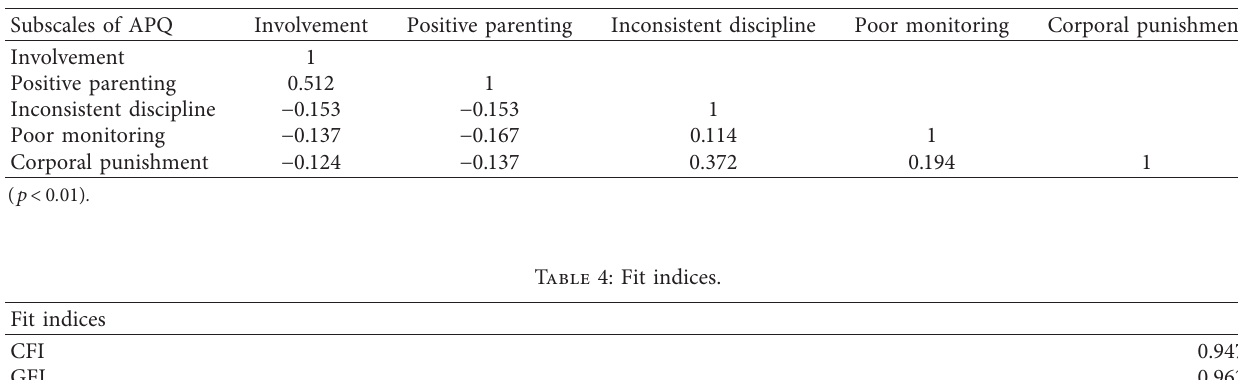
Table 3: Interfactor correlation.